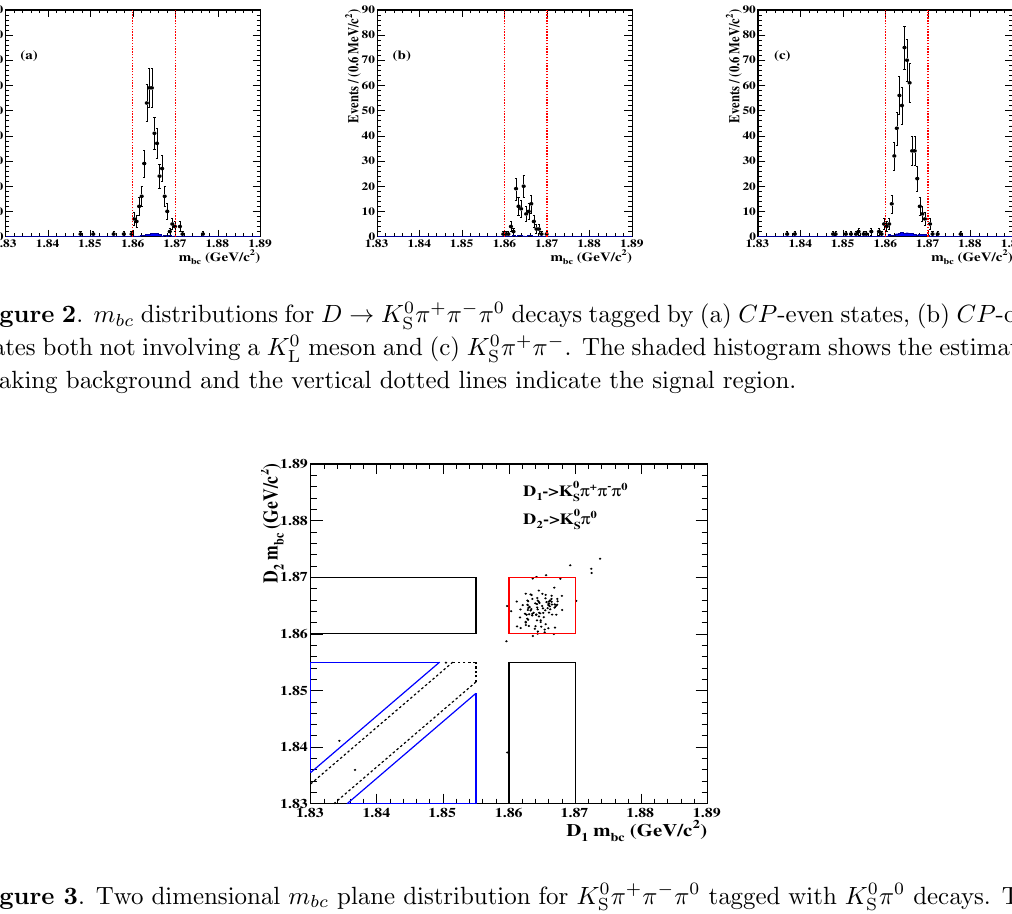
Figure 3 . Two dimensional m bc plane distribution for K 0 red square box indicates the signal region and the remaining boxes show the various sideband regions that are used to determine the combinatorial background